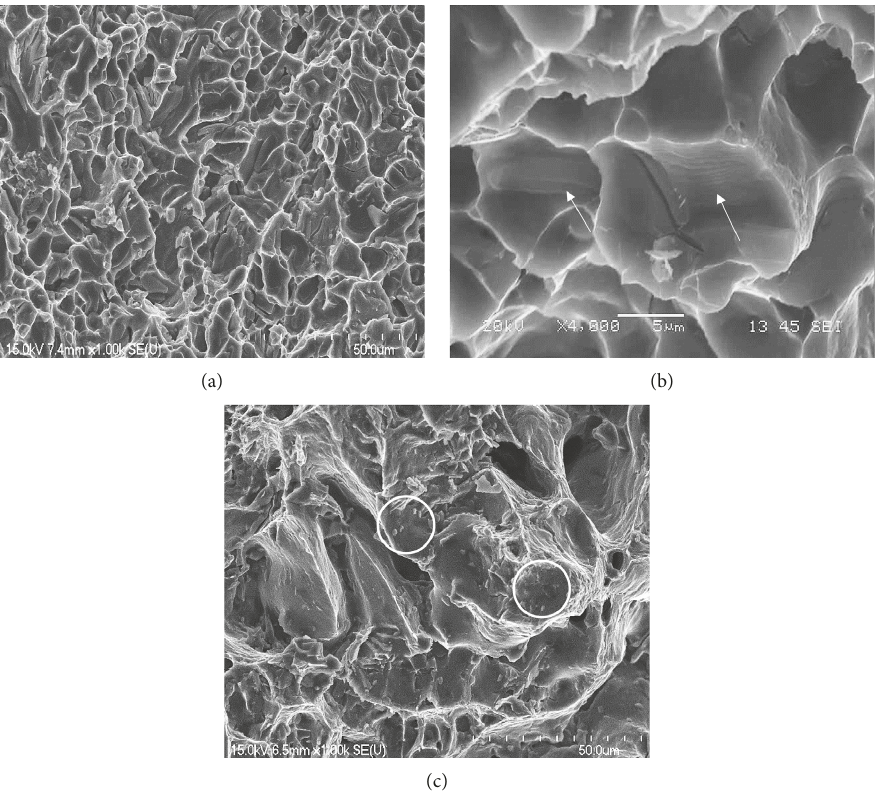
Figure 16: Secondary electron micrographs of the fracture surface of alloy B (a) after stabilization treatment (tested at 25 ° C), (b) a high magnification of (a), and (c) after testing at 250 ° C.